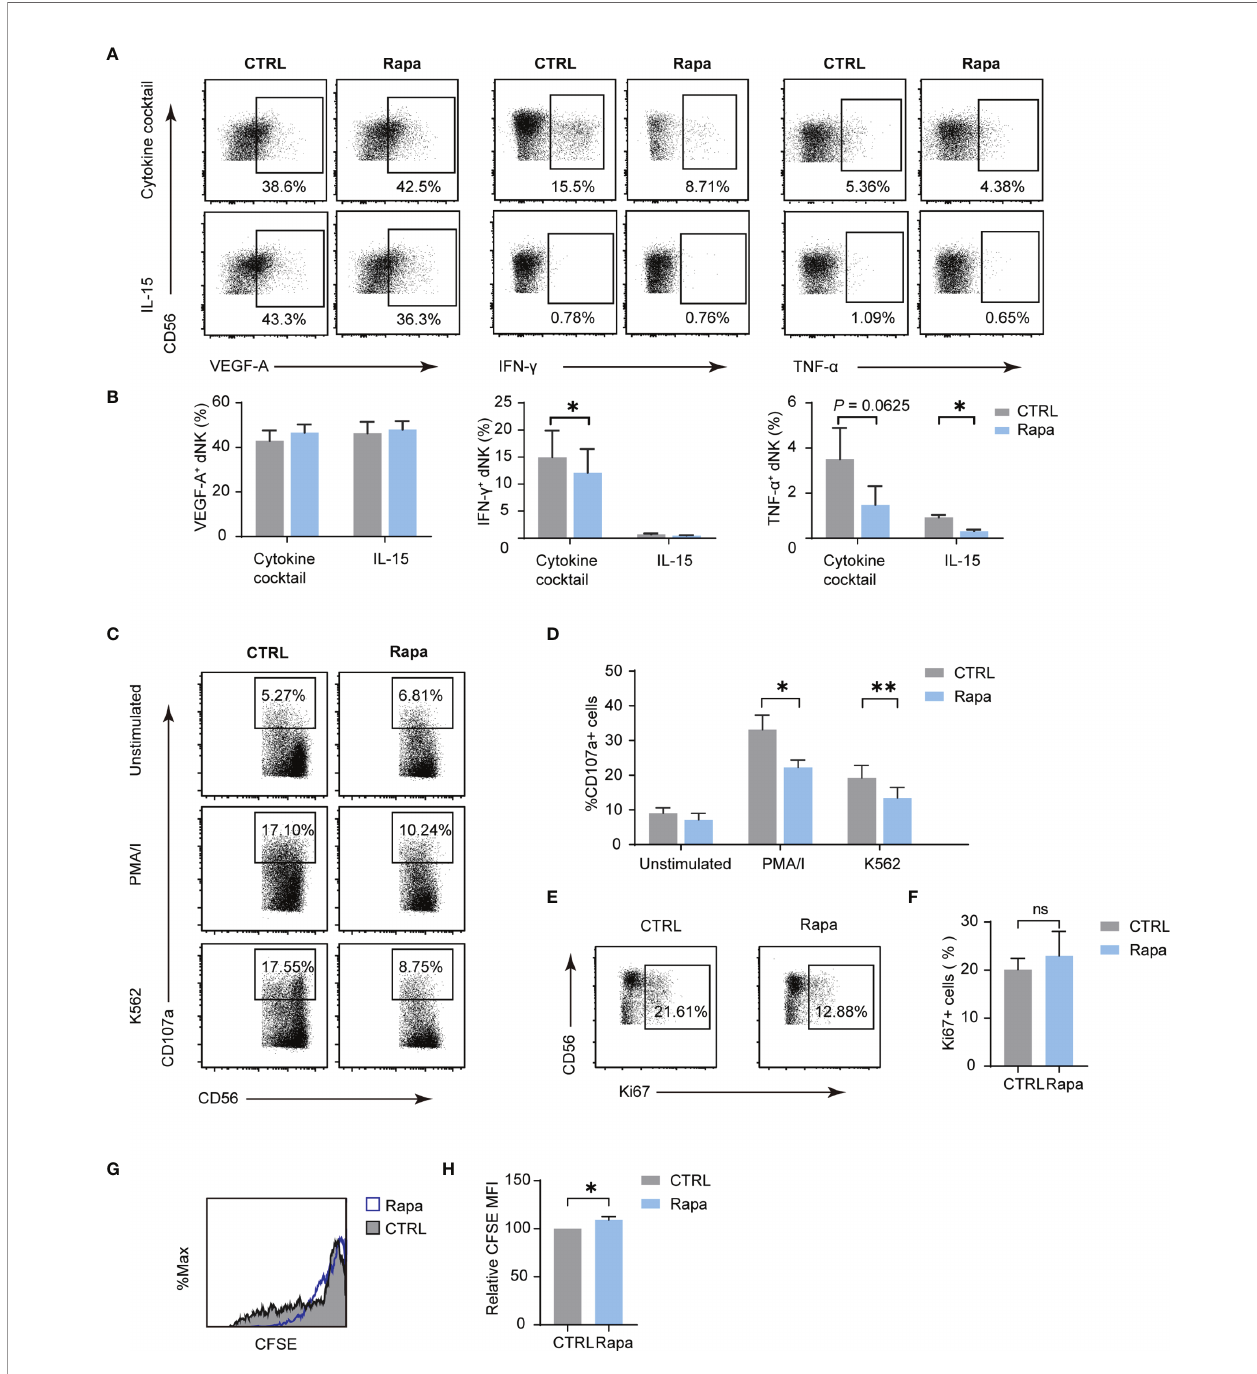
FIGURE 5 | The mTORC1 modulate dNK secretion, cytotoxicity abilities, and proliferation. Decidual immune cells (DICs) were cultured added with rapamycin (Rapa, 20 nM) to inhibit mTORC1 activity. As described above, decidual NK cells (dNK) cytokines production, cytotoxicity abilities, and proliferation were examined. (A, B) Rapa treatment lowered the frequency of IFN- g and TNF- a , even though VEGF-A production was not altered (n = 4-5, paired t-test). (C, D) Diminished mTORC1 activity reduced CD107a-dependent degranulation (n = 5, paired t-test). (E – H) Ki-67 positive dNK percentage was not in fl uenced by Rapa (n = 5, paired t-test); CFSE dilution assay showed a little increase in dNK CFSE MFI compared with controls (n = 4, paired t-test). ns, not signi fi cant; * P < 0.05; ** P <